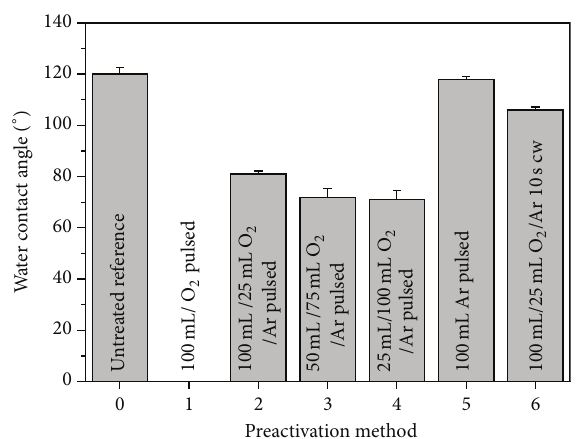
Figure 2: Water contact angles of fiber meshes measured after dif- ferent preactivation conditions (for the numbering of preactivation methods, refer to Table 1).